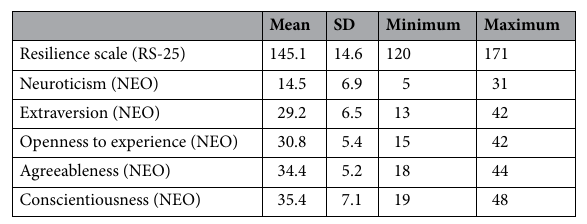
Table 1. Mean scores achieved on the resilience Scale (RS-25) and the